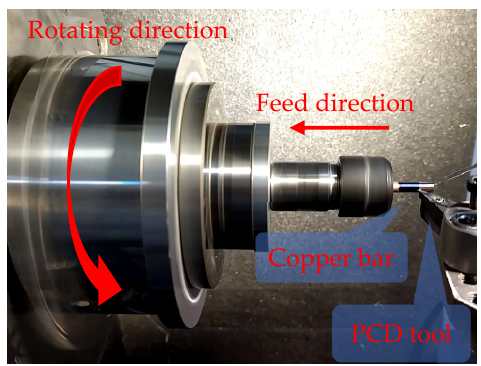
PCD tool Figure 19. Cutting experiment of cylindrical copper bar with a diameter of 4 mm. Figure 19. Cutting experiment of cylindrical copper bar with a diameter of 4